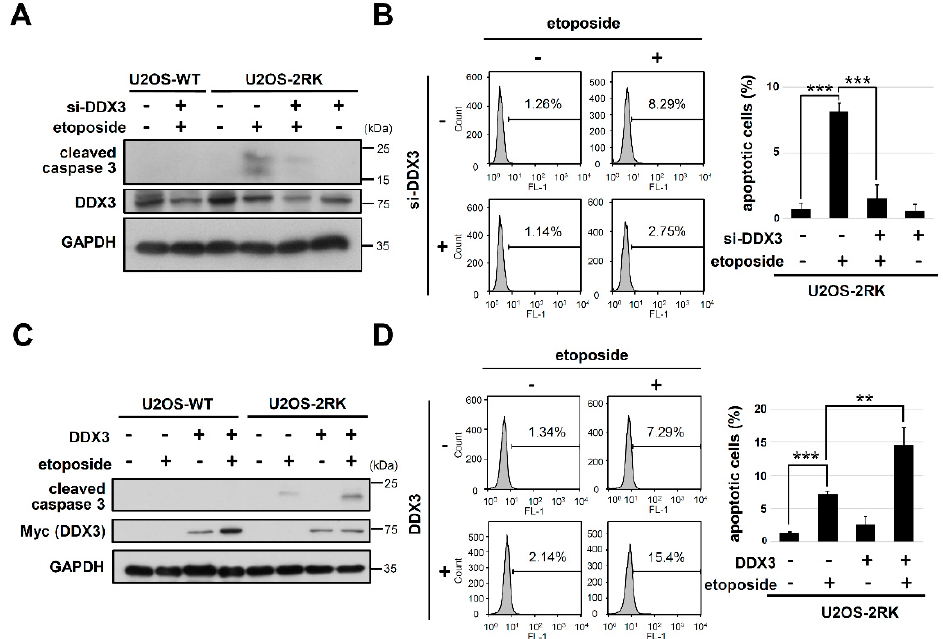
Figure 2. Knockdown of DDX3 attenuates hnRNPK MD -mediated apoptosis, whereas the overexpression of DDX3 promotes the induction of this apoptosis. ( A ) U2OS-WT and U2OS-2RK cells were transfected with or without DDX3 siRNA and were incubated for 24 h followed by etoposide (50 μ M) treatment for another 12 h. Cells were collected and were analyzed for the expression levels of cleaved caspase-3, DDX3, and GAPDH using specific antibodies. ( B ) Under the same treatment as described above, U2OS-2RK cells were collected and analyzed by TUNEL assay to determine the percentage of apop- totic cells using FACS (left). Quantitation of apoptotic cells in the TUNEL assay is shown (right). ( C ) U2OS-WT and U2OS-2RK cells were transfected with either pcDNA4 vector or Myc-DDX3 and were incubated for 24 h followed by treatment with etoposide (50 μ M) for another 12 h. Cell lysates were collected and were assessed by Western blot analysis to deter- mine the expression levels of cleaved caspase-3, DDX3, and GAPDH. ( D ) Under the same treatment as described above, U2OS-2RK cells were collected and analyzed by TUNEL assay to determine the percentage of apoptotic cells using FACS (left). Quantitation of apoptotic cells in the TUNEL assay is shown (right). ** as p < 0.01, *** as p < 0.001.